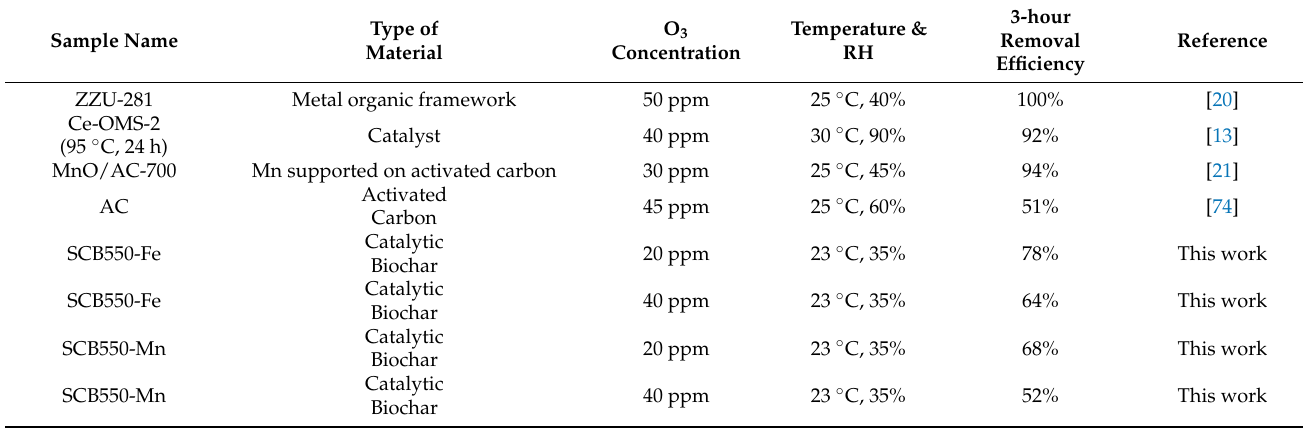
Table 3. 3-hour removal efficiency comparison of catalytic biochar with the literature.